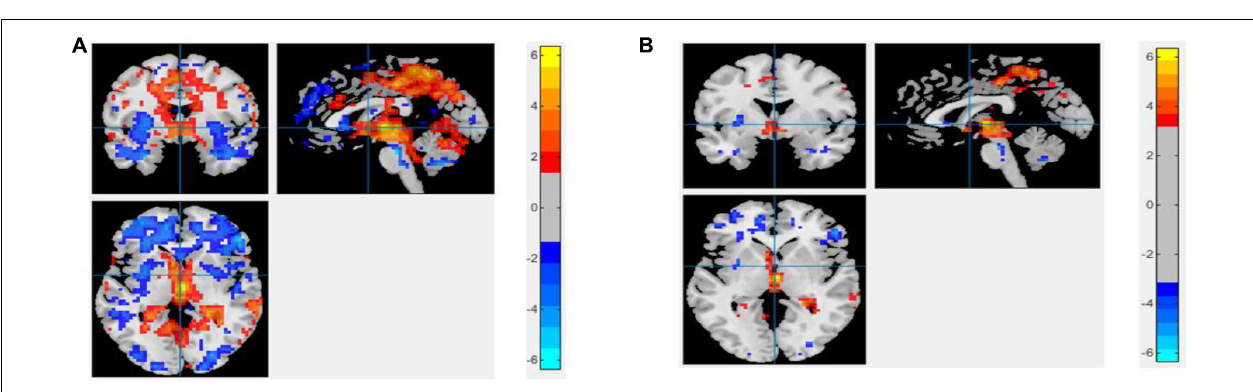
FIGURE 5 | An univariate statistical two-sample test on region of homogeneity (ReHo) voxel maps among two classification groups (A) AD vs. HC (B) MCIs vs. MCIc. The threshold value was set to p < 0.05. The hot and cold bar represent negative and positive